Question: Briefly state, in one sentence, what is plotted here.
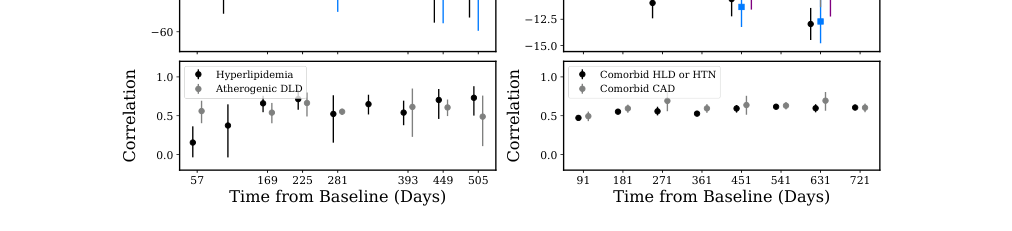
Answer: Observed and predicted mean progression of key outcomes for indications in the General Medicine therapeutic area. In each plot, we selected a key outcome and up to two cohorts (see Tables 5 and 8 for descriptions of outcomes and cohorts, respectively). The top panel compares the observed and predicted mean progression. For binary outcomes, we report response rate. The bottom panel reports Pearson correlation between observations and mean twins over time for continuous outcomes and AUC for binary outcomes, both as a measure of discriminative performance of the model. Error bars represent 95% confidence intervals. DTGs fit well mean progression across indications and clinically relevant cohorts.